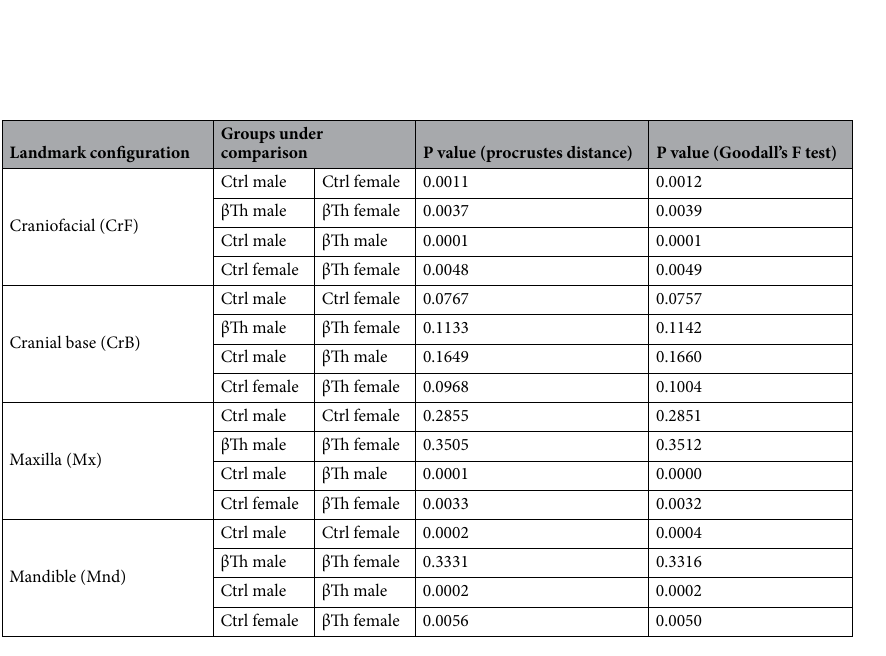
Table 2. Permutation test results for each of the 4 regions, comparing males to females and the Ctrl group to the βTh group. All results are based on 100,000 permutations without replacement. P values are reported to the 4th decimal